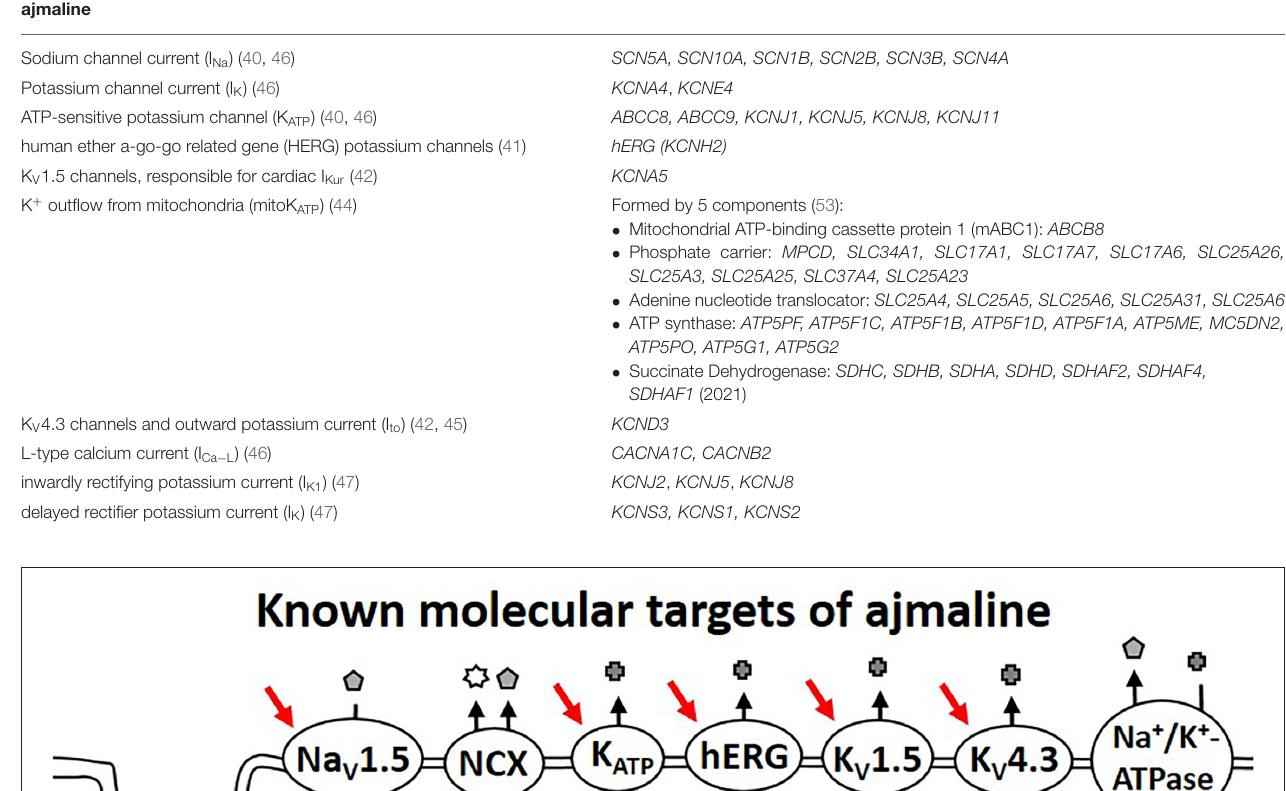
TABLE 1 | Known molecular targets of ajmaline and potential genes that they implicate. Protein or current described in functional studies targeted by ajmaline